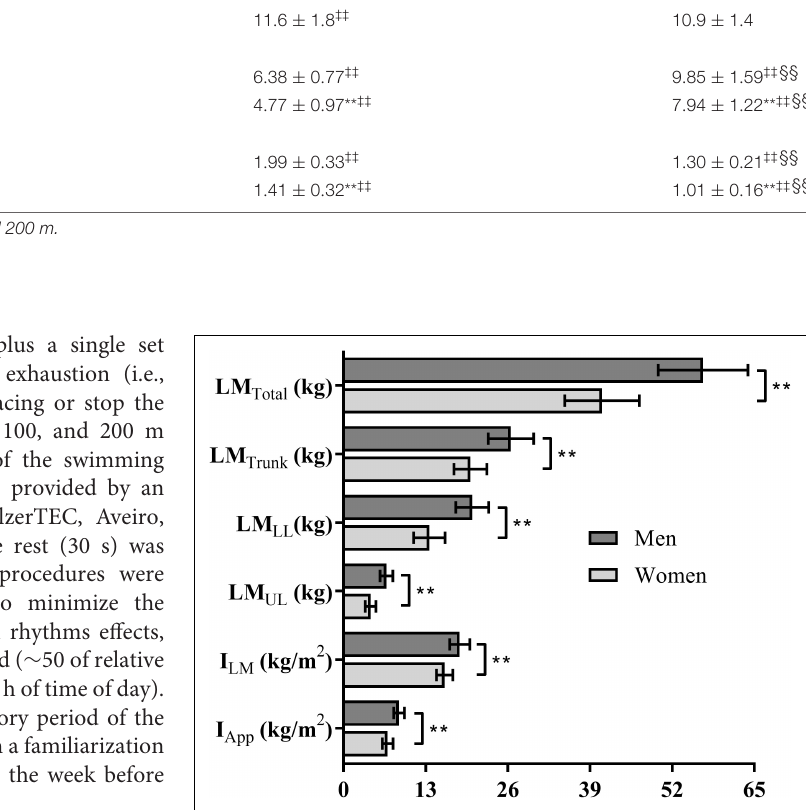
Dual-energy x-ray absorptiometry (DXA; Hologic R (cid:13) ,QDR Discovery Wi R (cid:13) ) was used for obtaining regional and whole- body composition, with the software Hologic APEX R (cid:13) displaying values for body mass, bone mass, body lean mass (LM Total ), trunk lean mass (LM Trunk ), upper limb lean mass (LM UL ), lower limb lean mass (LM LL ), lean mass index (I LM = LM × H 1 / 2 ), and appendicular muscle index (I App = LM App × H 1 / 2